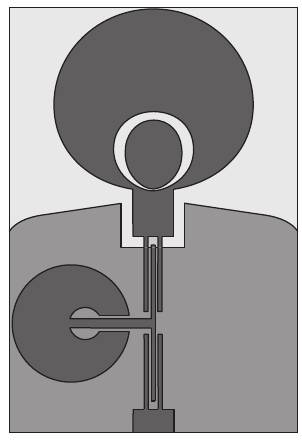
Figure 58: Printed monopole UWB antenna with an arc-shaped slot inserted in the patch and with a single-wing filter element employed to enhance the broadside antenna gain [63]. The multimode reso- nant filter is responsible for higher levels of cross-polarized field. Dark gray upper metal face, medium gray bottom metal face, and light gray dielectric substrate.